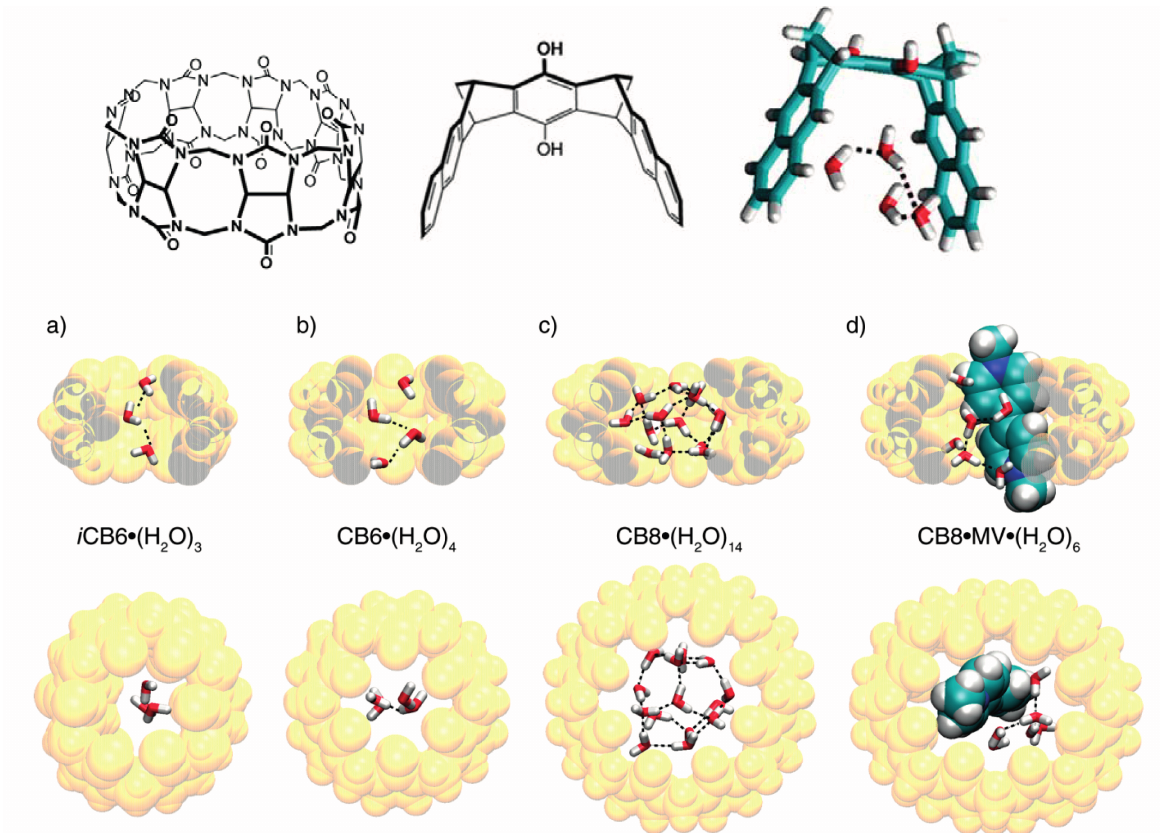
Figure 10. Host compounds for large hydrophobic binding contributions: cucurbiturils and a molecular clip with four water molecules. Cucur[n]biturils with increasing size: ( a ) Crystal structure of inverted-CB6 with three intracavity water molecules; ( b – d ) Snapshot from molecular dynamics (MD) simulations for ( b ) CB6, ( c ) CB8 and ( d ) CB8·viologen complexes with 4, 14 and six cavity water molecules, respectively. Top : Complexes viewed from the side (CB n atoms in the front removed for clarity); Bottom : Complexes viewed from the top. Reprinted from [33] with permission from